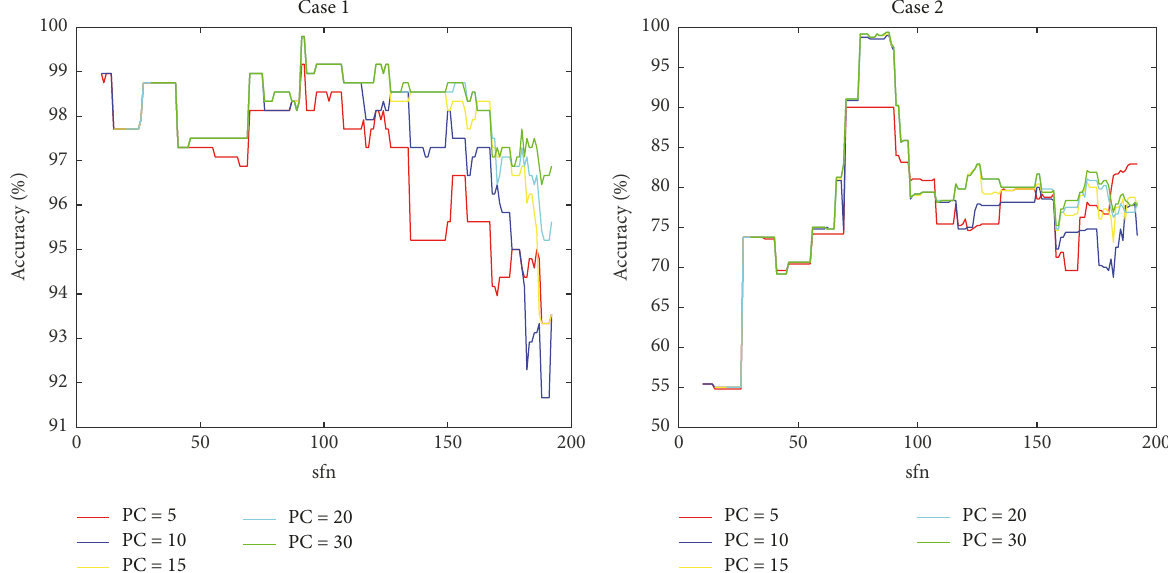
Figure 13: The diagnosis results obtained by OFS-FSASD-PCA-SVM using WPT with different dimension sizes for PCA. The PC represents the number of dimension sizes.